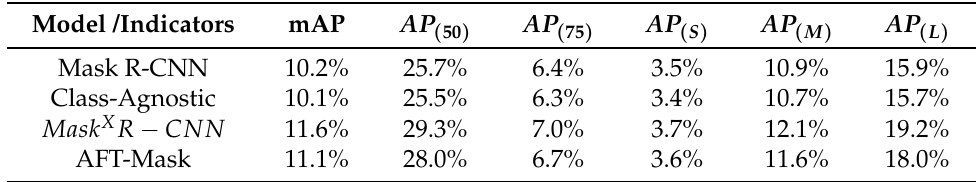
Table 3. Comparison of model performance under partitioning of semi-supervised dataset and training method in this